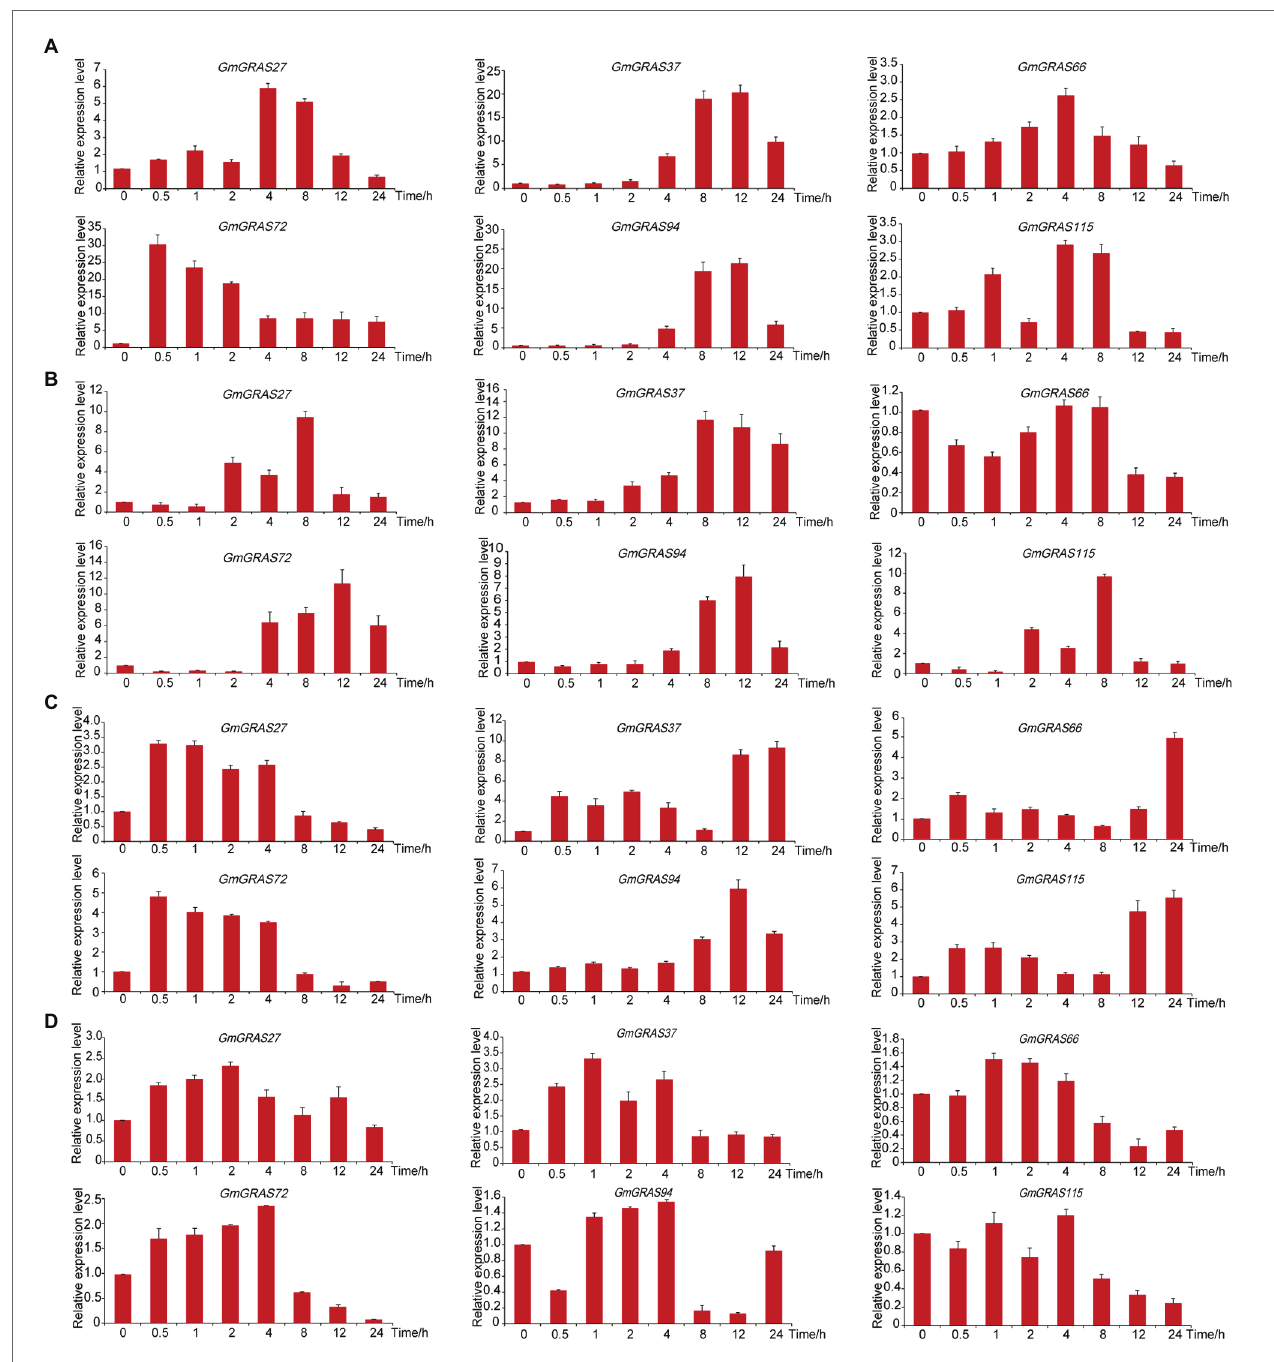
FIGURE 10 | Expression patterns of GmGRAS genes under drought, salt, abscisic acid (ABA), and brassinosteroid (BR) treatment. (A–D) Expression levels of six GmGRAS genes, as measured using quantitative real-time PCR (qRT-PCR), under drought (A) , NaCl (B) , ABA (C) , and BR (D) treatment applied for 0, 0.5, 1, 2, 4, 8, 12, and 24 h. qRT-PCR data were normalized using the soybean Actin gene (U60506) and are displayed relative to 0 h. The x -axes show the duration of treatment and y -axes depict relative expression level (error bars indicate SD). The data are shown as means of three biology repeats ±